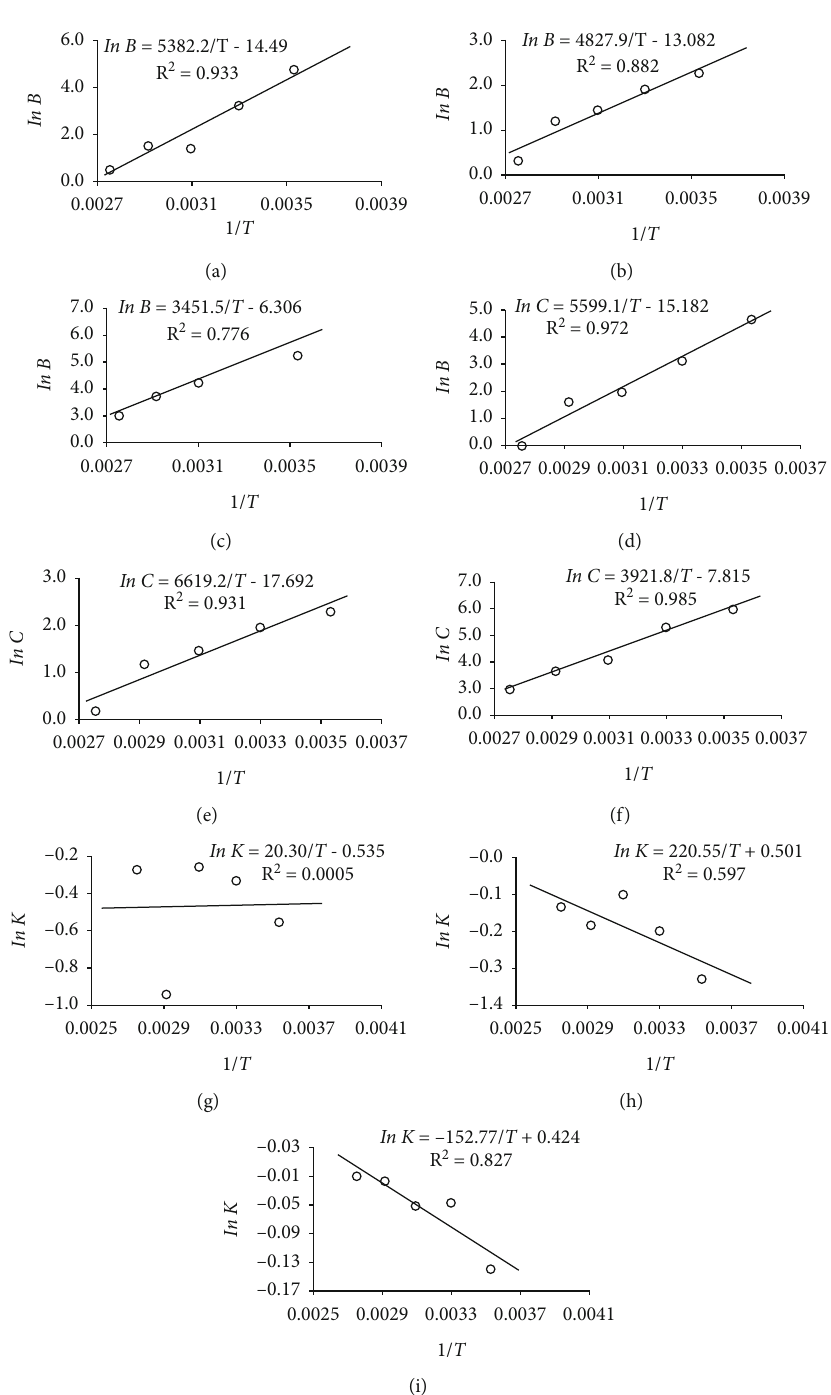
Figure 7: BET model B values ((a) cellulose, (b) lignin, and (c) hemicellulase), GAB model C values ((d) cellulose, (e) lignin, and (f) hemicellulase), and K values ((g) cellulose, (h) lignin, and (i) hemicellulase) as a function of